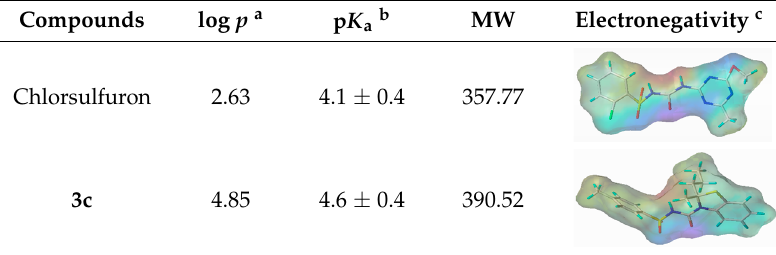
Table 3. Chemical property comparisons of chlorsulfuron with 3c .